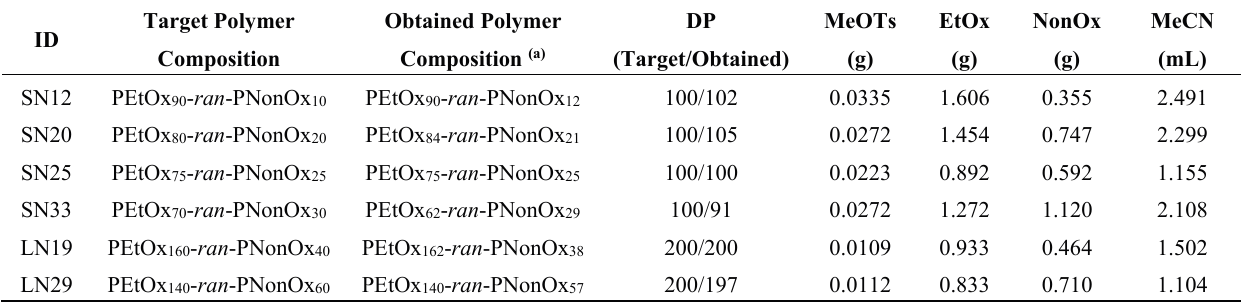
Table 2. Reagents quantities and obtained copolymer